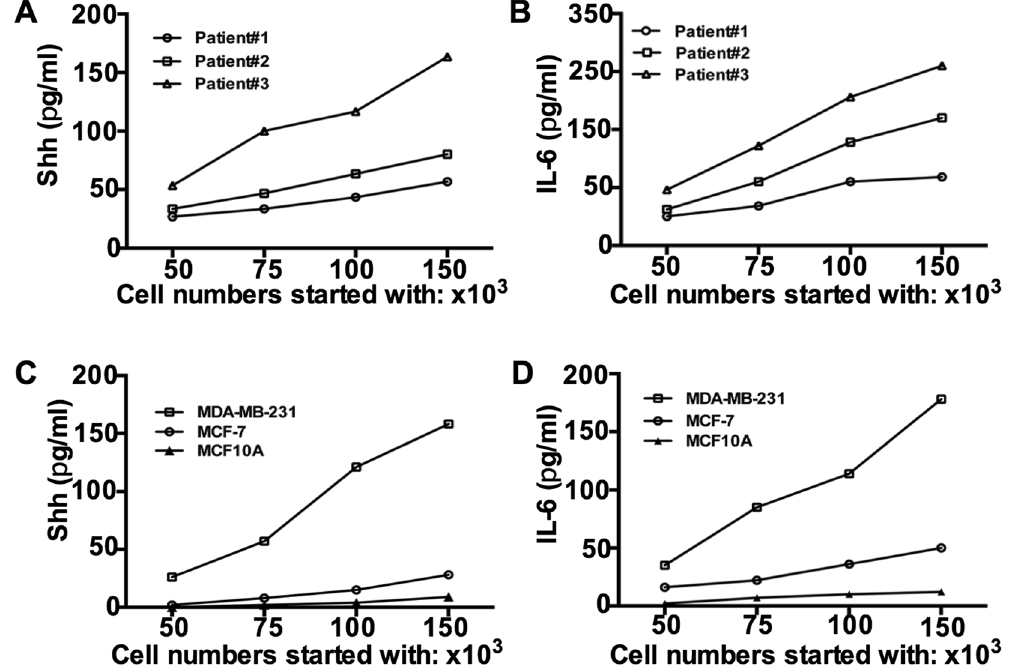
Figure 3. Tumor cell number determines the Shh and IL-6 concentration quantitatively. Freshly collected cells from patient’s tumor samples were cultured for 48-hours in a serum free medium and concentrations of ( A ) Shh and ( B ) IL-6 were measured. Similarly, concentrations of ( C ) Shh and ( D ) IL-6 were measured from MDA-MB-231, MCF-7 and MCF10A cell